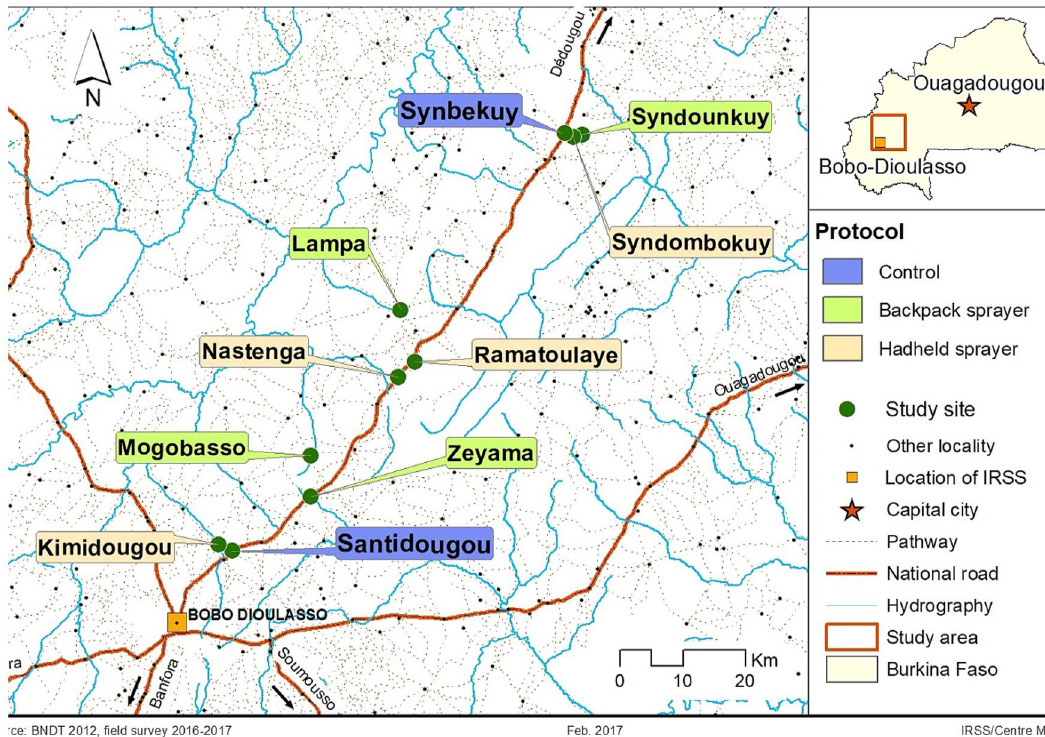
Figure 1. Localization of the study sites in south-western Burkina Faso. This map was created under QGIS version 2.18 Las Palmas. link: https:// chang elog. qgis. org/ en/ qgis/ versi on/2.